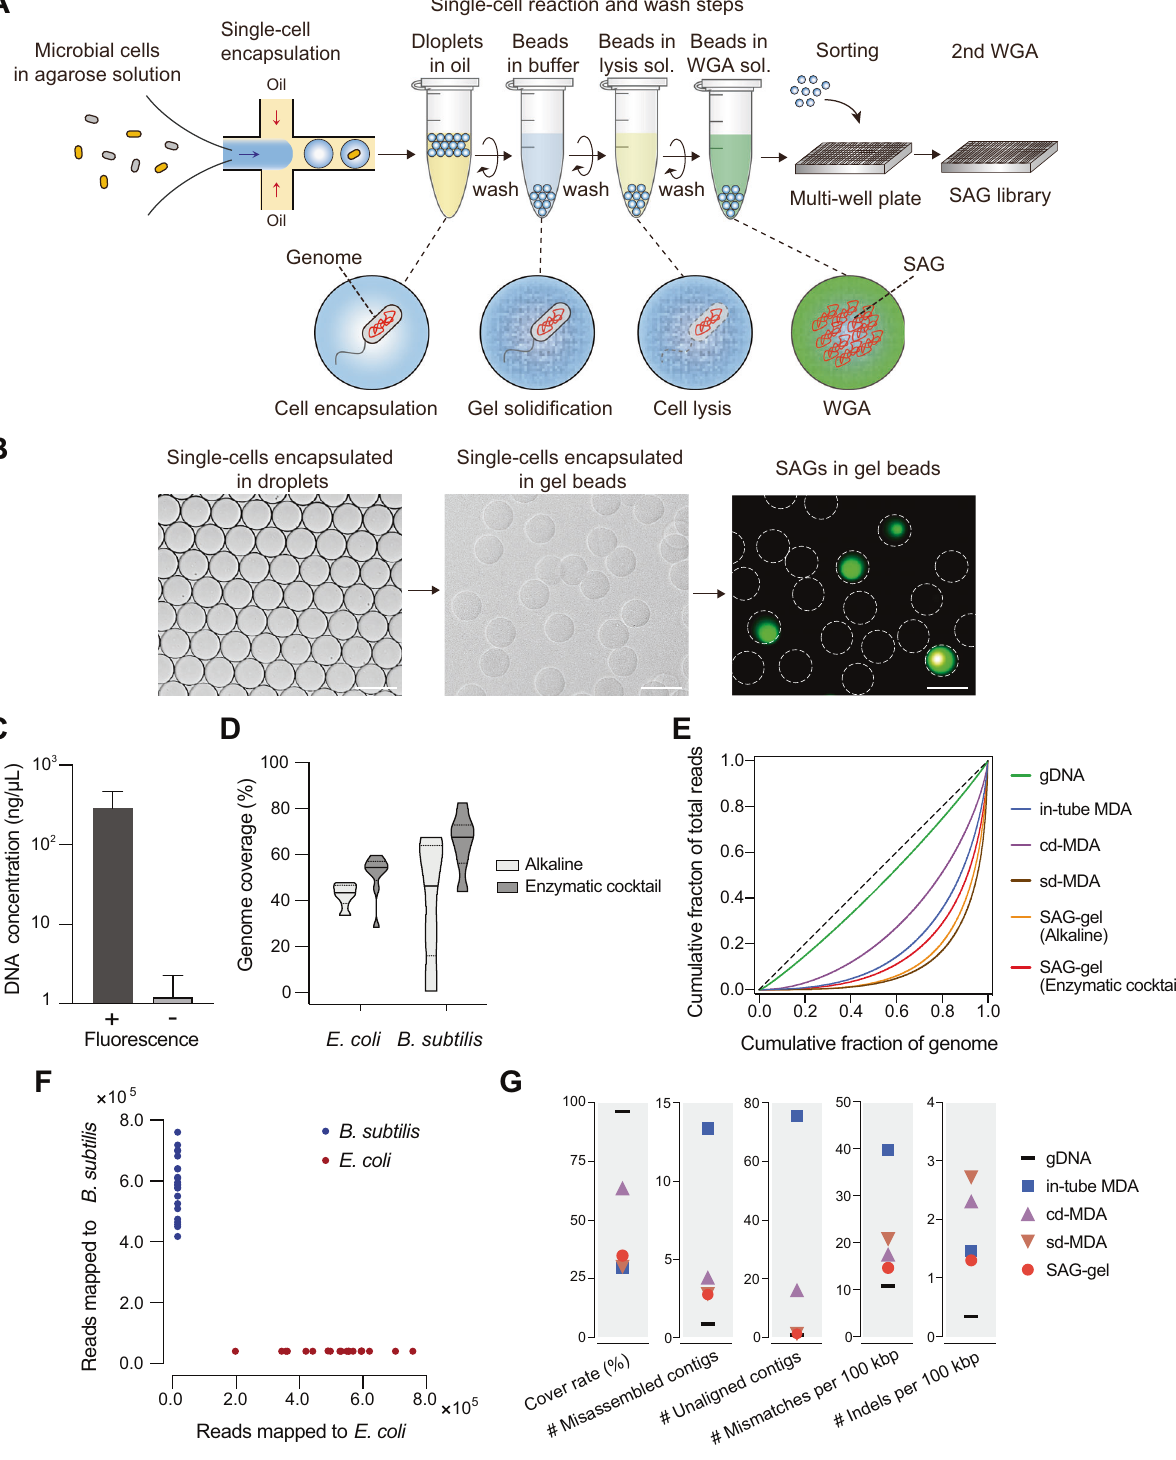
We compared the CDSs of SAGs, six from RS1 and six from RS2, with the reference genome of HIMB11, showing that each strain shared unique gene sets (Fig. 4). In total, 34,423 genes classi fi ed into 6274 clusters were identi fi ed. Only 6.9% (2372/34423) were found in one SAG, of which 92.8% (2202/2372) could not be annotated. KEGG pathway analysis revealed that the module completion ratio (MCR) of the glucose/mannose transport